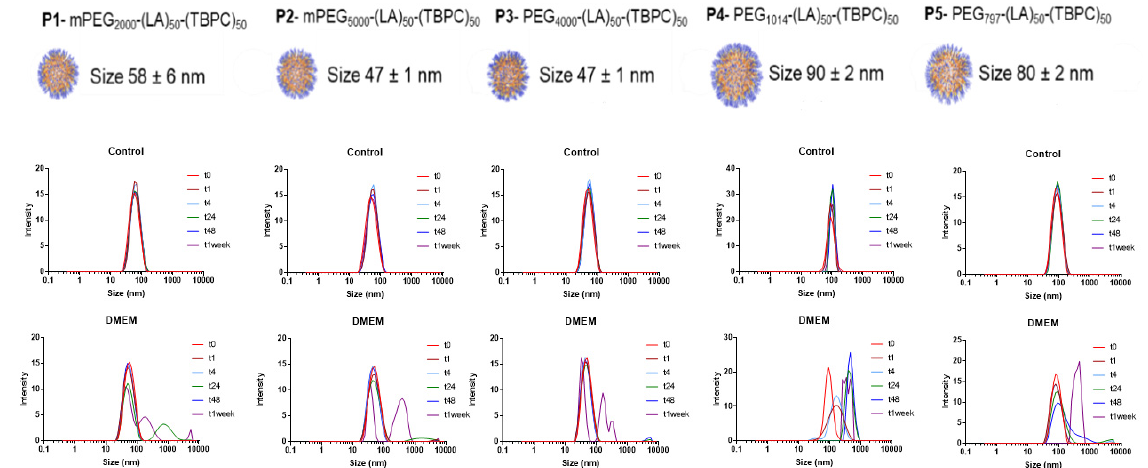
Figure 1. Dynamic Light Scattering (DLS) plots for NP formulations of P1–P5 under cool-chain storage (‘control’) conditions